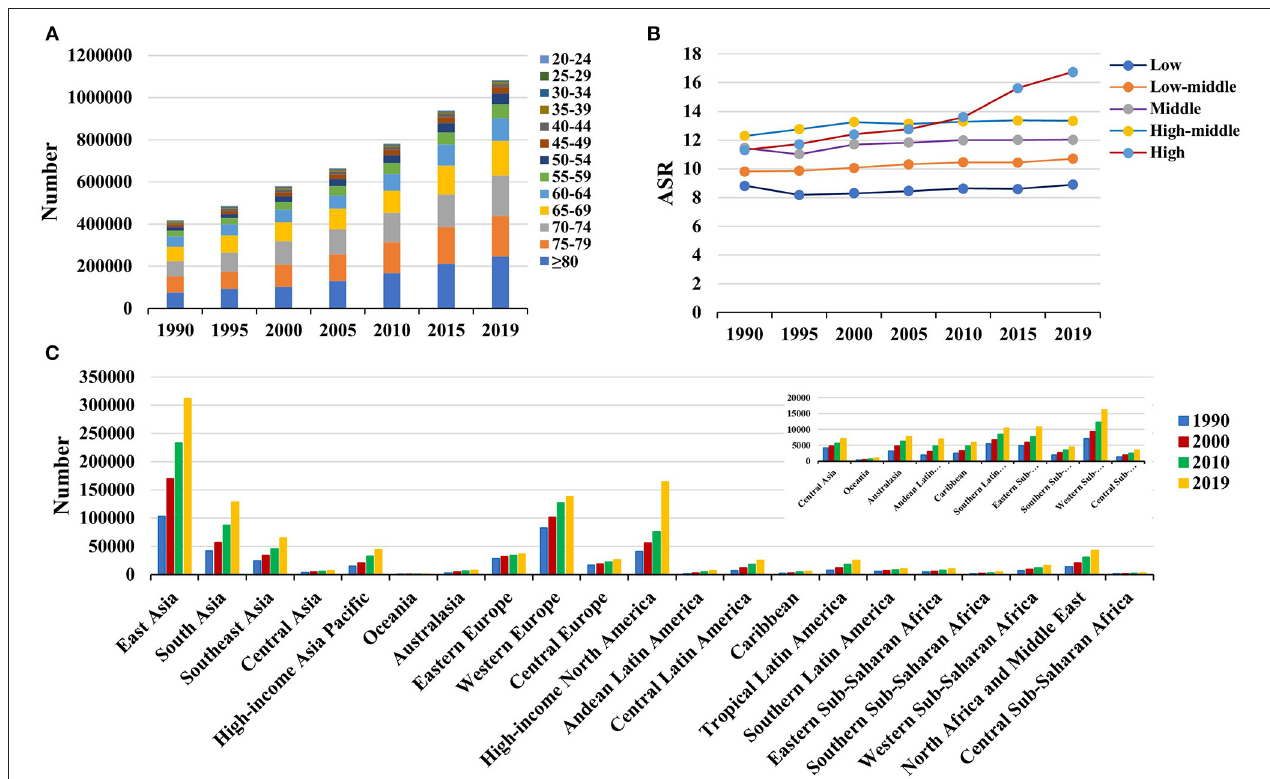
FIGURE 2 | The distribution of Parkinson’s disease incidence in age groups, SDI areas and geographic regions from 1990 to 2019. (A) was the incident number in age groups; (B) was the ASIR in SDI areas; (C) was the incident number in geographical regions. ASIR, age-standardized incidence rate; SDI, sociodemographic index.